Question: In one sentence, what is this figure communicating?
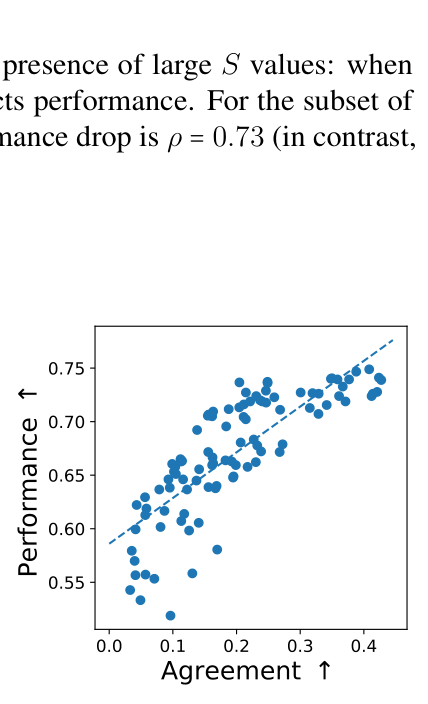
Answer: 4: We find high correla- tion (ρ = 0.8) between the perfor- mance drop when Xi is missing and the model’s Ui value: high Ui coin- cides with large performance drops (red), but low Ui can also lead to per- formance drops. The latter can be further explained by large S so Xi is necessary (green).